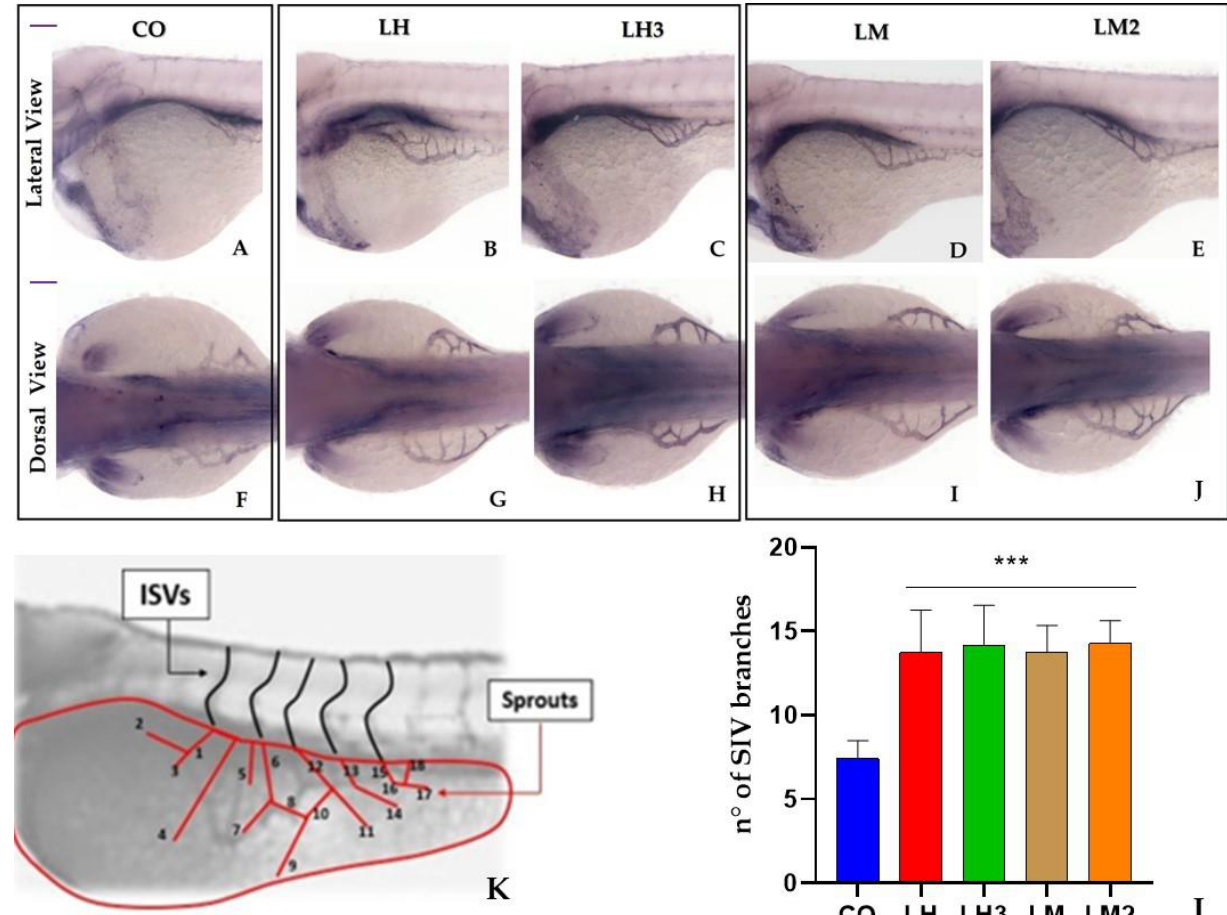
Figure 5. Purified extracts from Helix aspersa caused an increased number of interconnecting vessels in the SIVP: Images from ( A ) to ( J ) show representative staining of an AP assay performed in control and treated embryos, with enlargement of the SIVP region at 72 hpf. ( A – E ) lateral view; ( F – J ) dorsal view. The scheme in ( K ) depicts the counting of ectopic sprouts. The graph in ( L ) shows the average number of SIVP branches. Data are representative of two replicates ( n = 20 for each group) and are shown as the mean ± standard deviation; *** p < 0.001 vs. control group. Statistical analysis was performed with GraphPad version 8.3.3 (GraphPad Software, Inc., La Jolla, CA, USA).